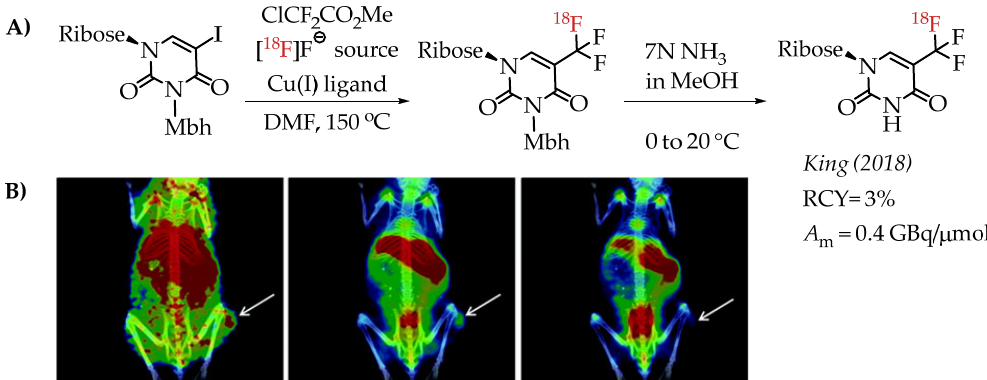
Figure 9. ( A ) Radiolabelling of trifluridine by King et al. ( B ) Representative PET/CT images selected from a 90 min dynamic PET scan of a mouse bearing an HCT116 ‐ derived tumour, following the administration of [ 18 F]trifluridine. The white arrows indicate the tumour (adopted from [61]; RCY: radiochemical yield; A m : molar activity).